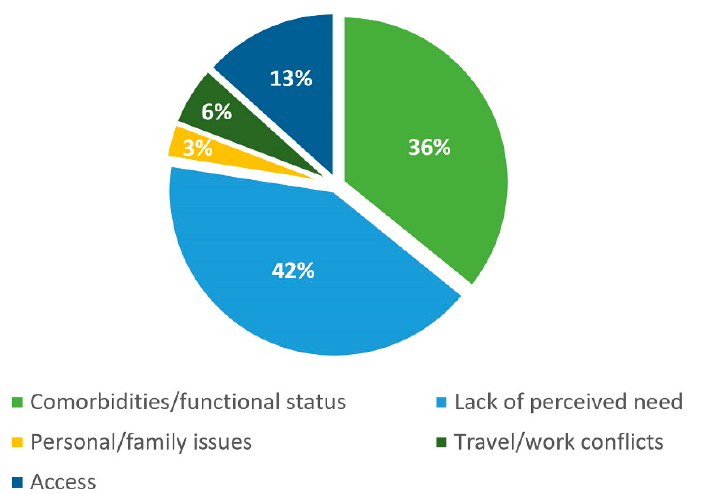
Figure 1. Distribution of barriers to cardiac rehabilitation (CR) enrollment of patients with heart failure with reduced ejection fraction (HFrEF) according to the five subscales of CRBS*: comorbidities/functional status (items 8, 9, 13, 14, 15, 17, 21), lack of perceived need (items 3, 5, 6, 11, 16), personal/family issues (items 4, 7, 18), travel/work conflicts (items 10, 12), and access (items 1, 2, 19, 20). *Item 22 (Other reason) is not classified. CR: cardiac rehabilitation; CRBS: Cardiac Rehabilitation Barriers Scale; HFrEF: heart failure with reduced ejection fraction.